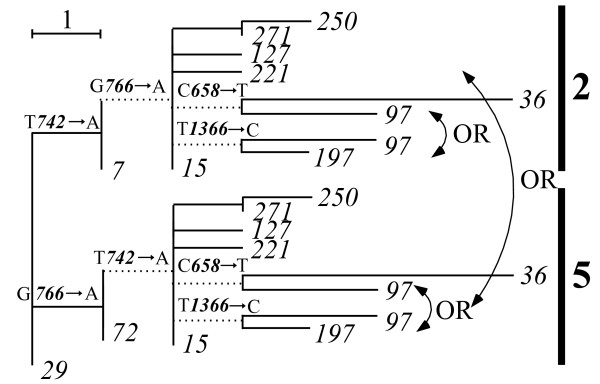
Typical example of two phylogenetic positions in mosquitoes. Example of alternative phylogenetic positions caused by the shared-site uncertainty illustrated in Fig. 7a. It remains ambiguous whether the 15th haplotype should be branched from the 7th haplotype (node) in group 2 or from the 72nd haplotype (node) in group 5. This uncertainty was a major influence on the phylogeny, because the 72nd haplotype became the ancestor of the 250th, 271st, 127th, 221st, 36th, 97th, and 197th haplotypes. Here, the last three haplotypes yielded an additional uncertainty of their locations. Here, An→C denotes a substitution from A to C at the n th site.